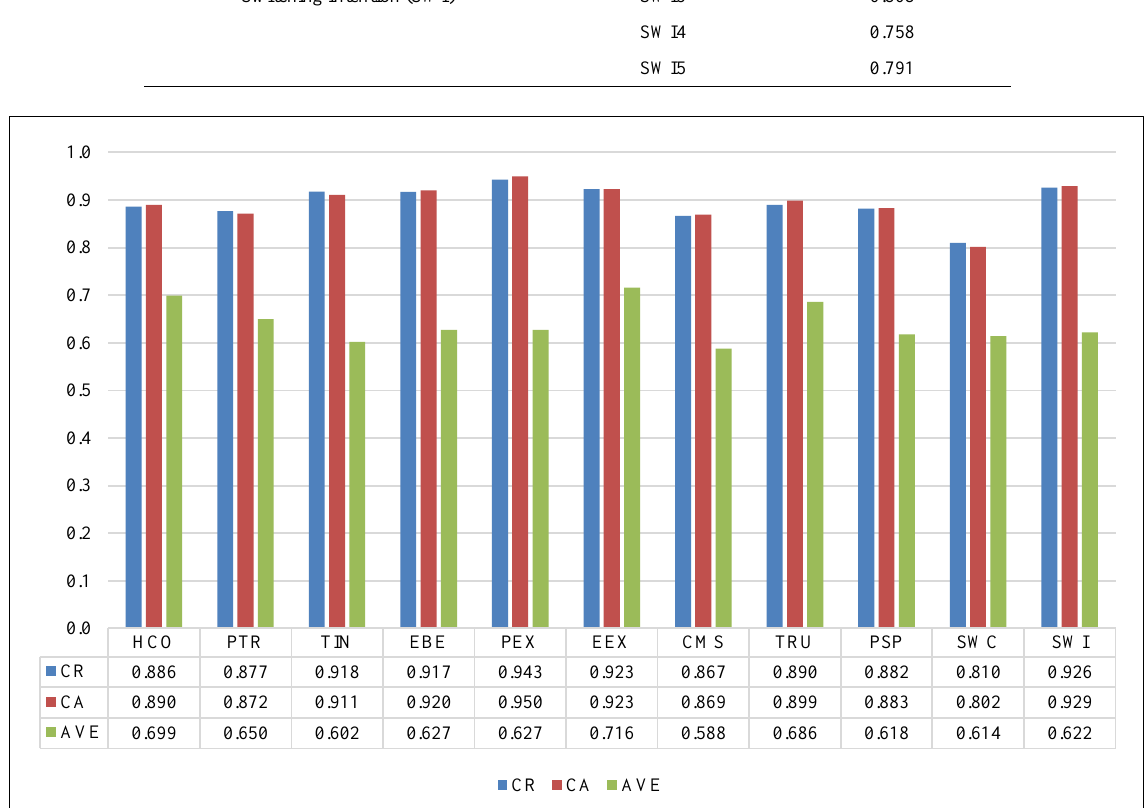
Figure 3. Composite reliability (CR), Cronbach’s alpha (CA), and average variance extracted